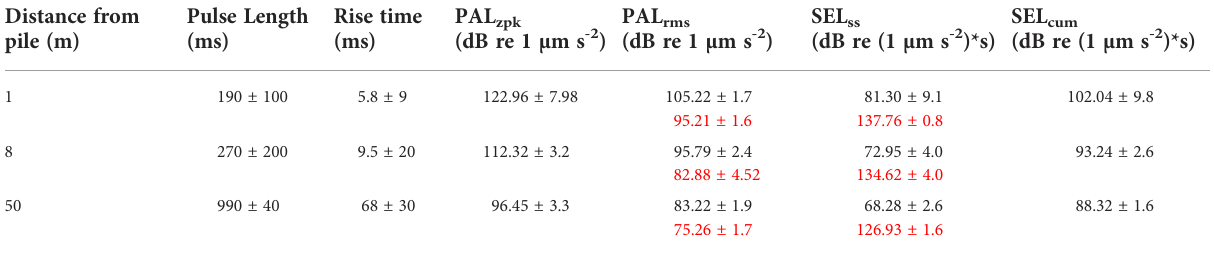
TABLE 1 Particle acceleration levels from the IH (black) and VH (red) at three different distances from the pile. Distance from pile